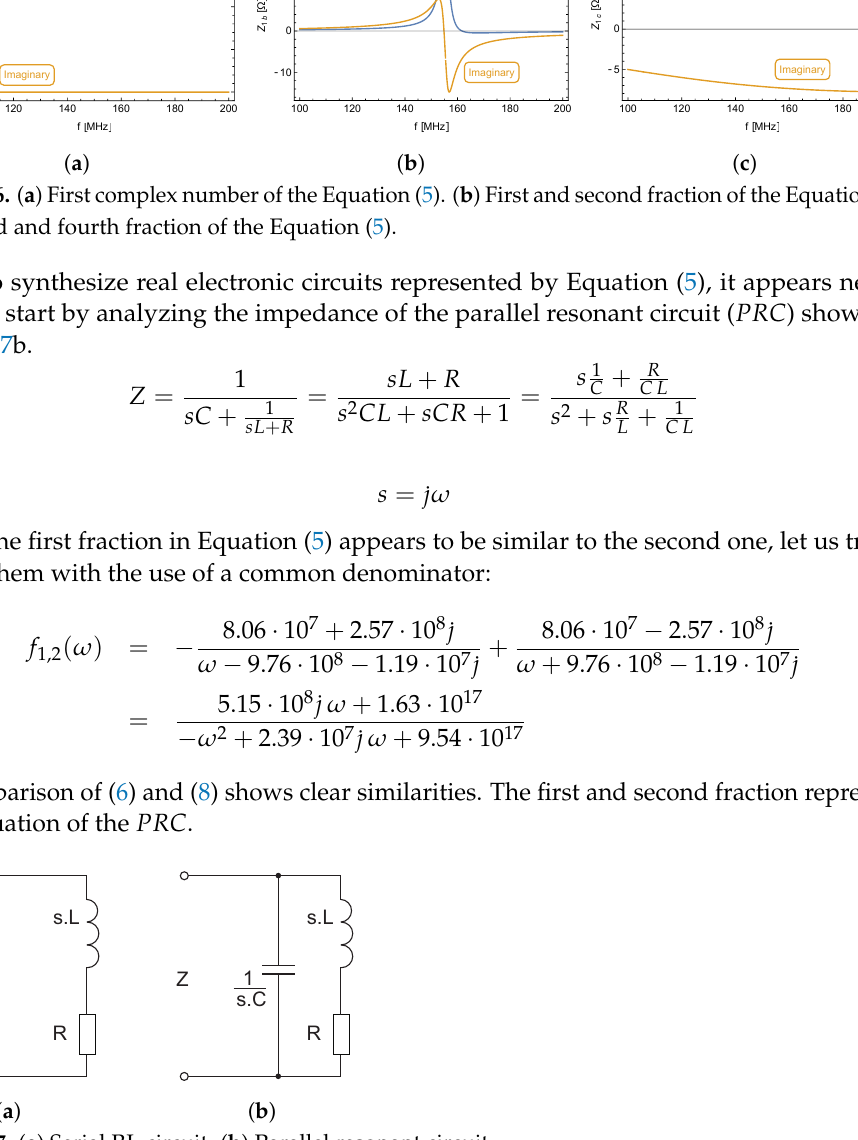
Figure 7. ( a ) Serial RL circuit. ( b ) Parallel resonant